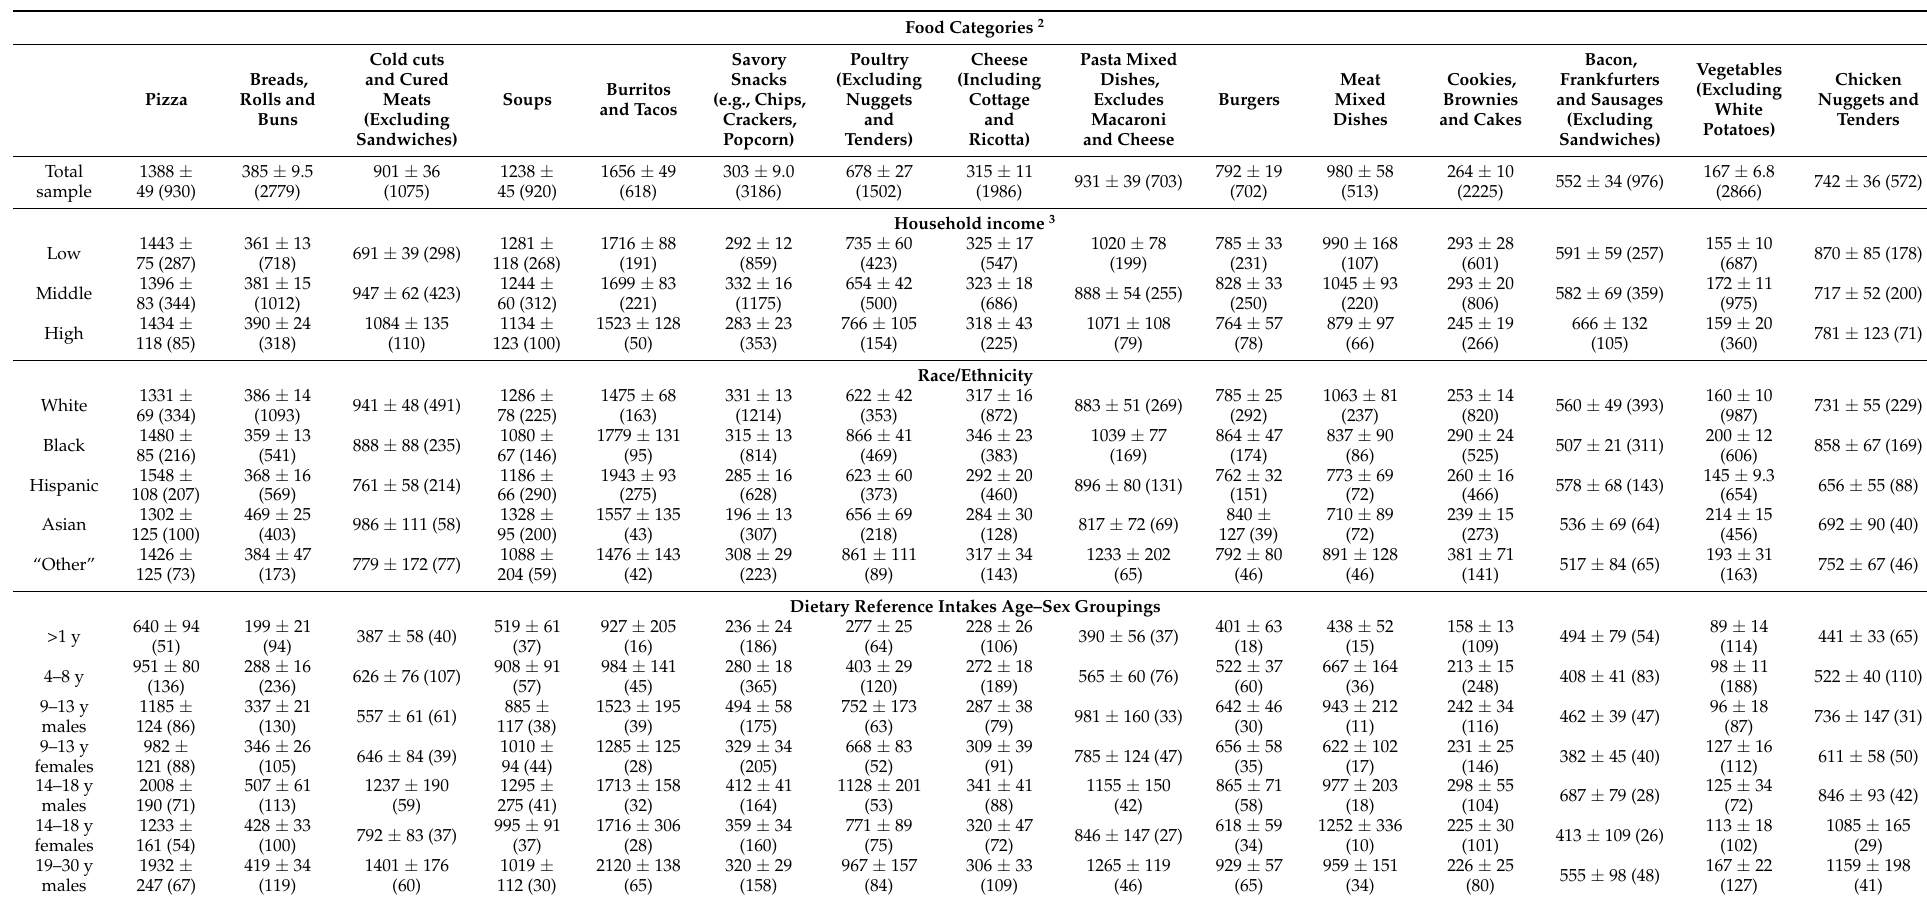
Table 2. Mean sodium intakes [mg/day ± SE ( n )] by top sodium-contributing categories, NHANES 2017–2018, for the total sample and by sub-groups, consumers only 1